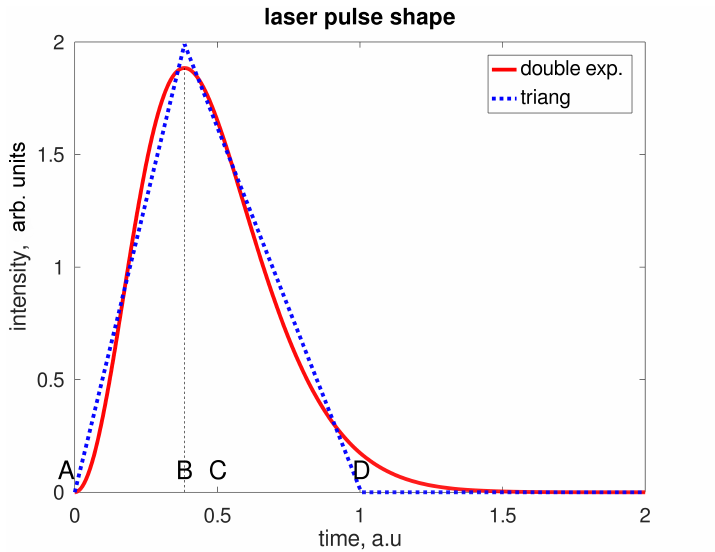
Figure 4. Approximation of a double exponential laser pulse with a triangular function having an equal area. The parameters of the triangular function are determined so that the modal value is the same as that of the double exponential, and to ensure an even ratio for the areas to the left and to the right of the modal value (indicated by the dotted line). Point A represents the beginning of the pulse; B is the time where the peak value is reached; C is the middle point between A and D; and D is the end point of the triangular pulse.